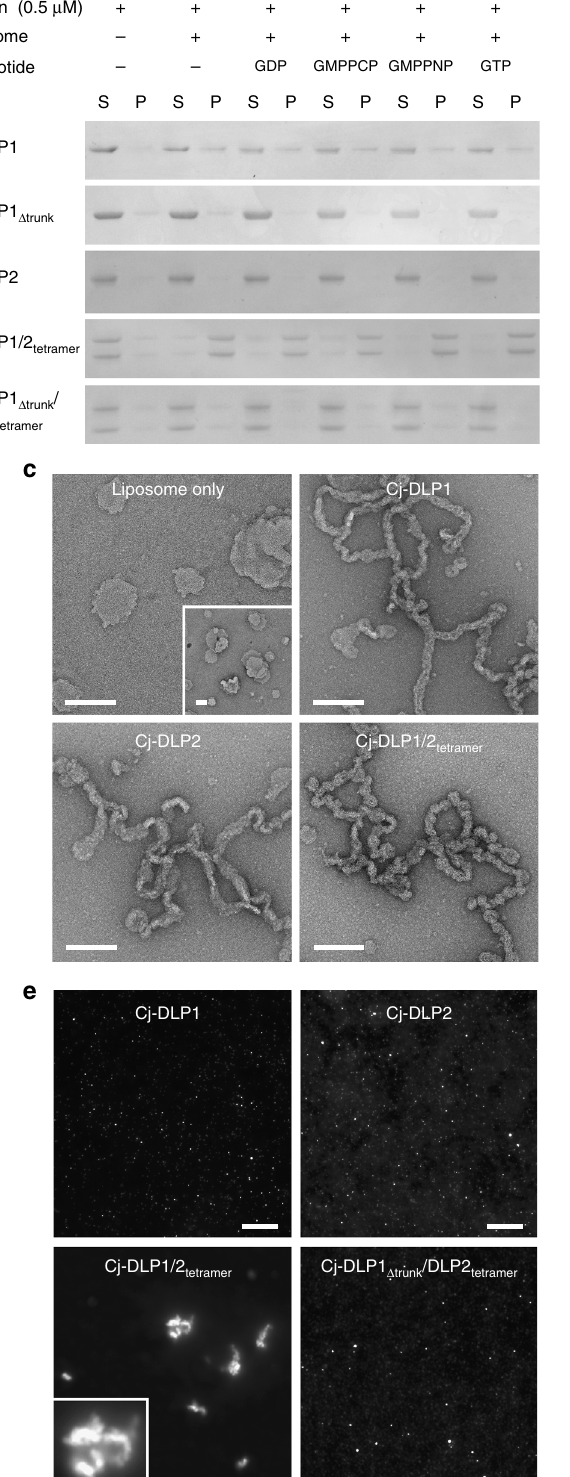
concentration (0.5 µM), dynamic light scattering (DLS) was